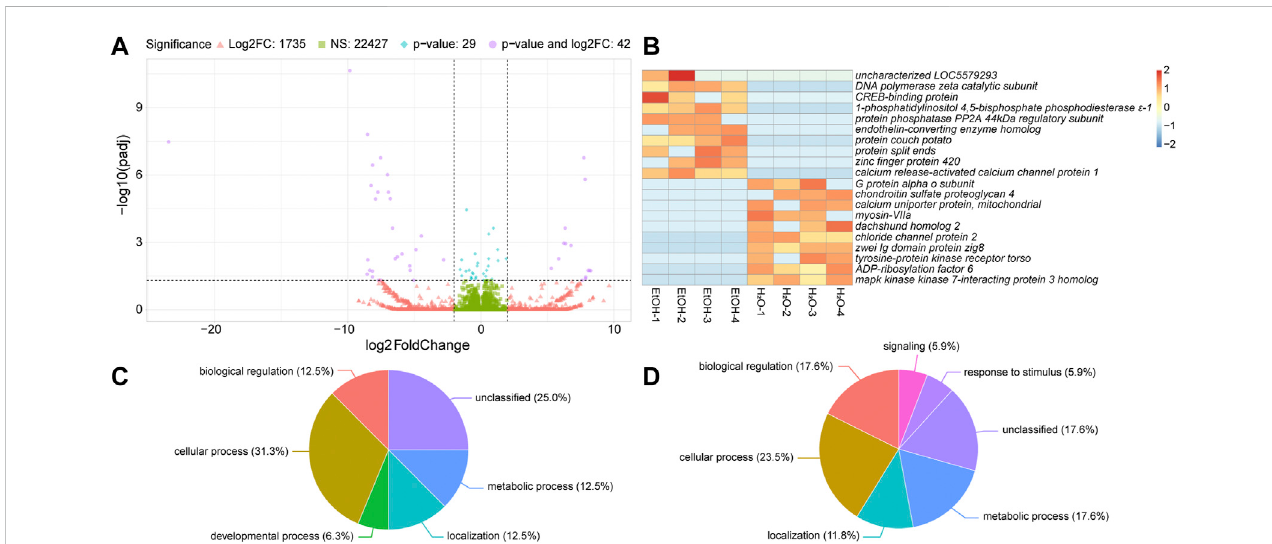
FIGURE 4 Differential gene expression between ethanol (EtOH) and water-fed irradiated mosquitoes. (A) . Volcano plot illustrating the differential expression patterns between transcripts with elevated expression in EtOH-fed mosquitoes (negative values) and elevated expression in water-fed mosquitoes (positive values). See Figure 2 legend for detailed description of volcano plot. (B) . Heatmaps showing the ten most signi fi cantly differentially expressed transcripts with at least four-fold increase in ethanol-fed mosquitoes or water-fed mosquitoes. Each column represents a single biological replicate, and each row representsanindividualtranscript. (CandD) .Piechartsofgeneontology(GO) analyses ofgenesupregulated inwater-fedmosquitoesrelativeto ethanol-fed mosquitoes (C) and upregulated in ethanol-fedmosquitoes relative to water-fedmosquitoes (D) . See Figure 2 legend for detailed description of these